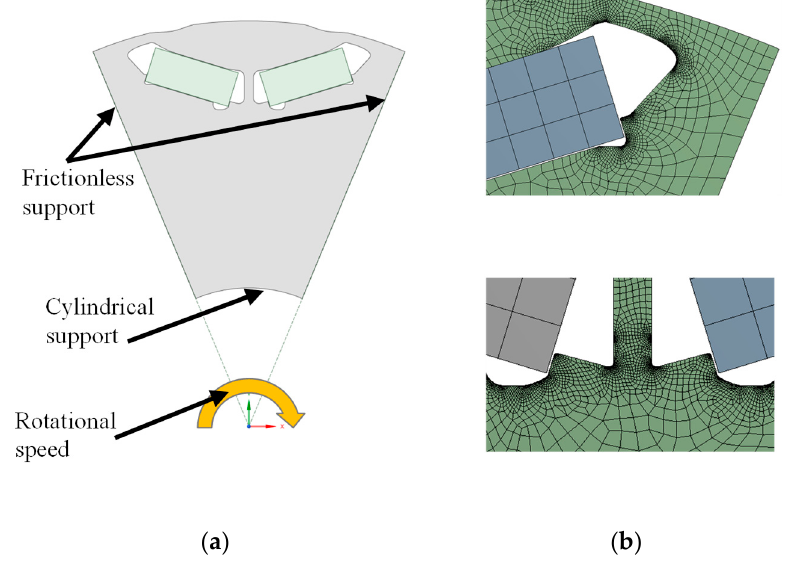
Figure 8. ( a ) Boundary conditions for the FEA model, ( b ) mesh refinement at intersection points where maximum mechanical stress can occur. Table 2. Geometries of the investigated rotors.